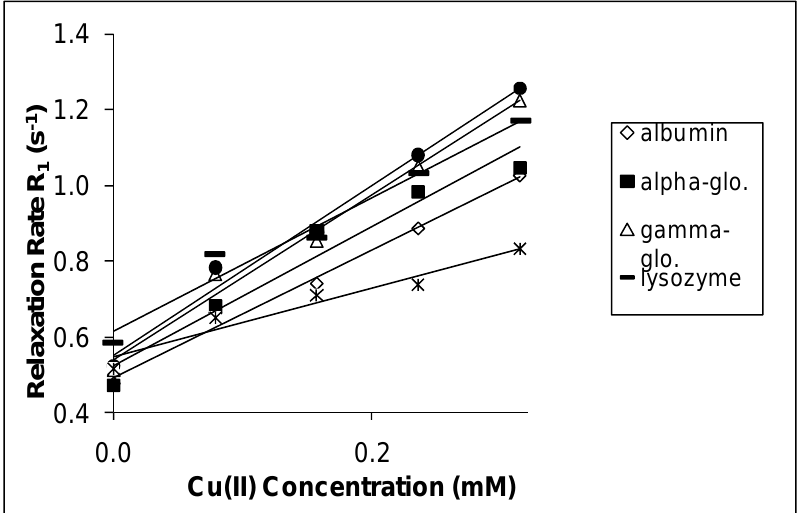
) of protein solutions versus concentration of Cu(II). 1